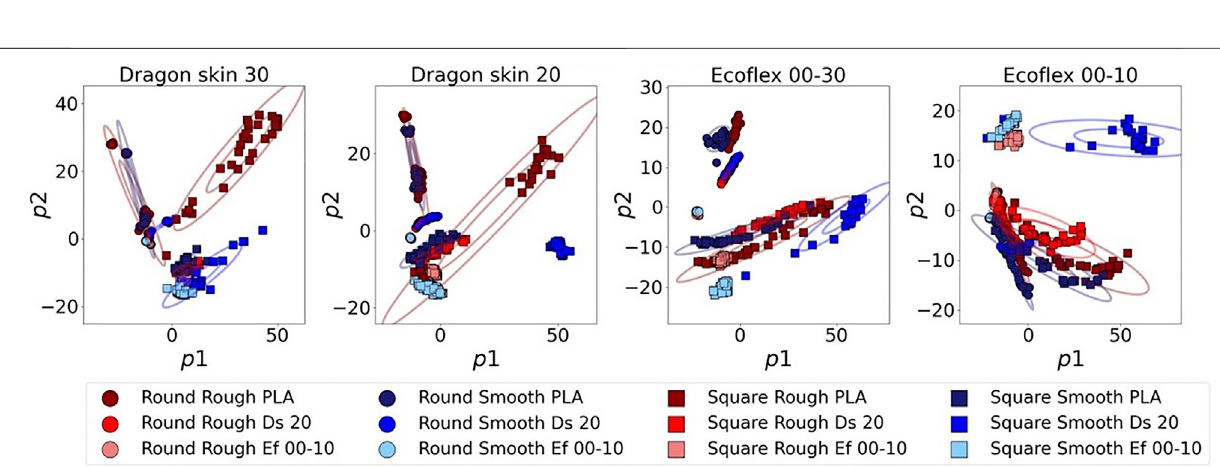
Frontiers in Robotics and AI |